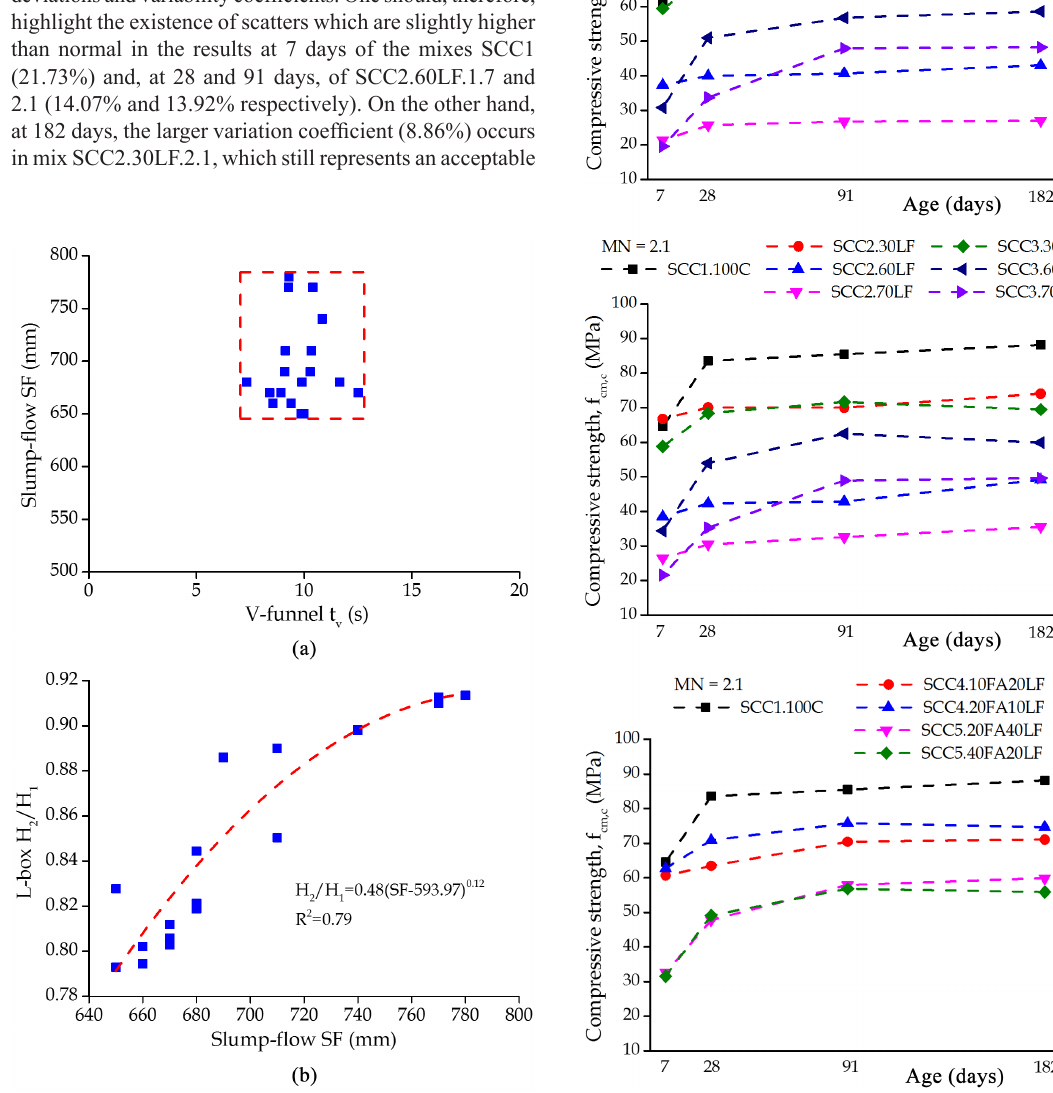
Figure 7. Slump-flow/V-funnel (a) and L-box/slump-flow correlations (b).